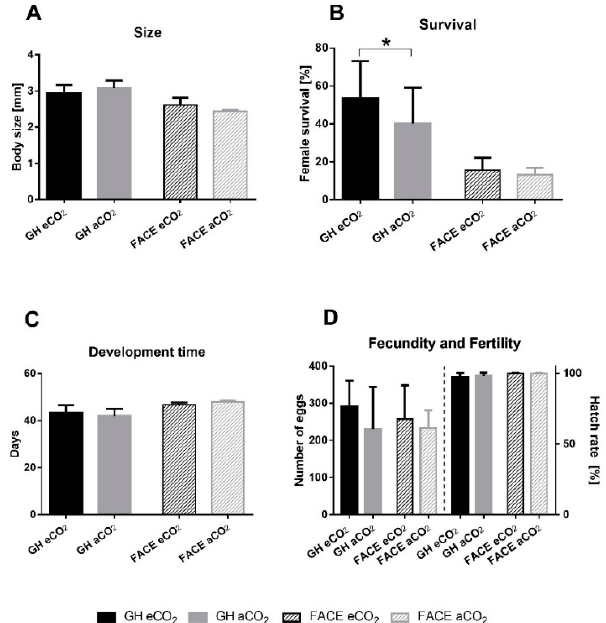
Figure 1. Life history parameters of mealybug females reared under eCO 2 and aCO 2 in the greenhouse and in the VineyardFACE facility. Data displayed as means + SD. Statistically significant differences between CO 2 treatments are marked with *. Solid columns display greenhouse data (GH), and hatched columns display data from the VineyardFACE experiment. ( A ) Body size of females at the onset of oviposition. ( B ) Survival of females. ( C ) Development time of females from 1st instar to oviposition. ( D ) Fecundity, shown as the total number of eggs laid per female, and fertility, shown as the percentage of hatched crawlers from these